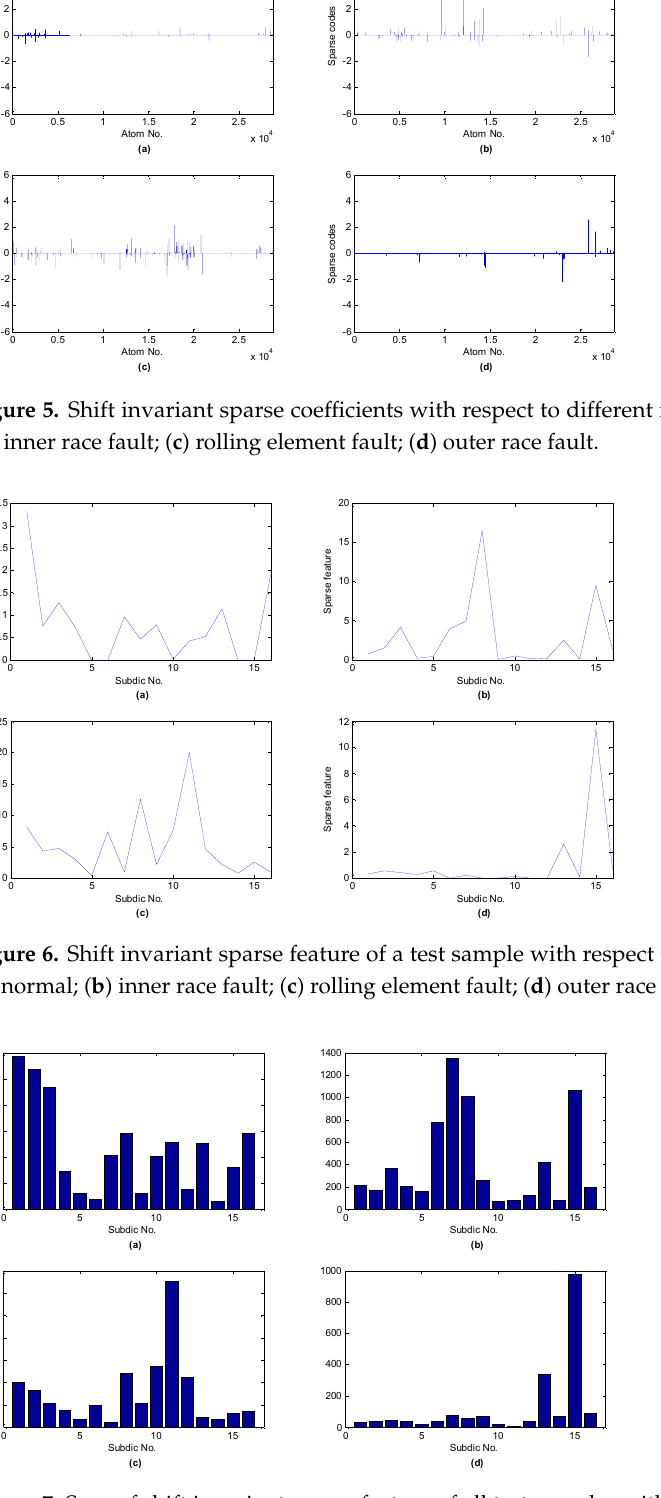
Figure 7. Sum of shift invariant sparse feature of all test samples with respect to different running statuses: ( a ) normal; ( b ) inner race fault; ( c ) rolling element fault; ( d ) outer race fault.